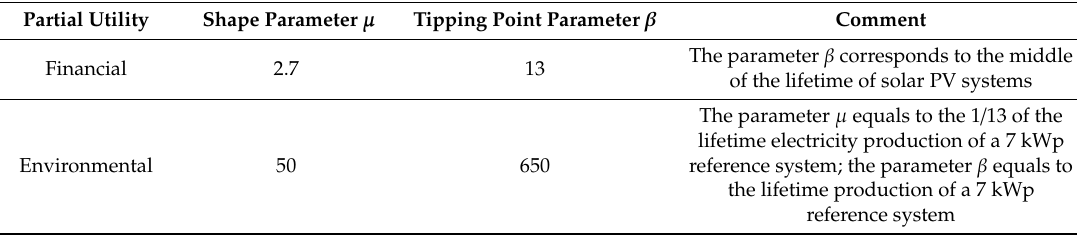
Table A11. Parametrization of the S-shape partial utility